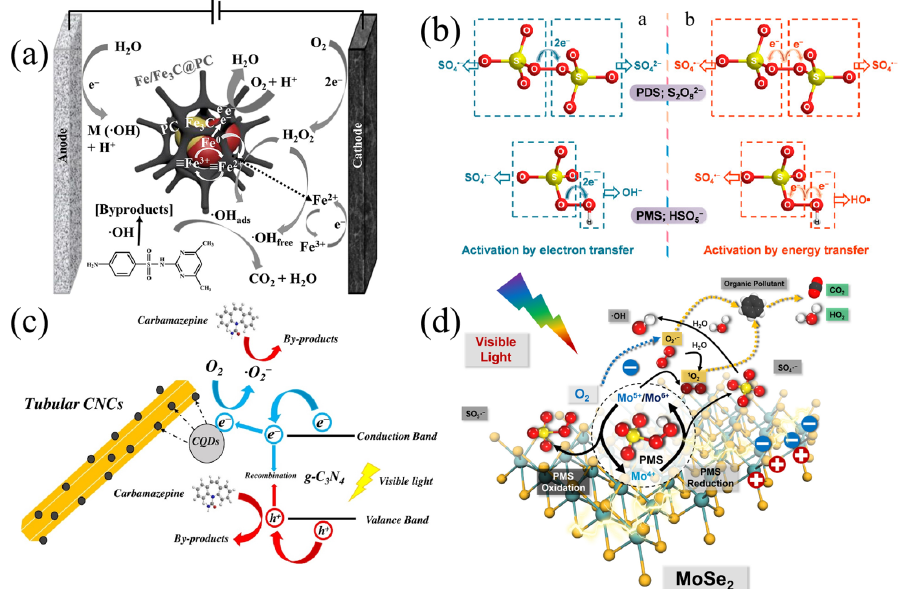
Figure 9. Illustrations of mechanisms of different AOPs. ( a ) Proposed scheme of the mechanism of the hetero-EF process catalyzed by Fe/Fe 3 C@PC. Reproduced with permission from [146]. ( b ) Activation of PDS and PMS through a electron transfer and b energy transfer reactions. Reproduced with permission from [149]. ( c ) Schematic illustration of the photocatalytic mechanism using carbon quantum dots modified tubular graphitic carbon nitride as material. Reproduced with permission from [150]. ( d ) Possible mechanisms of the visible light-driven MoS 2 /PMS system. Reproduced with permission from [151].